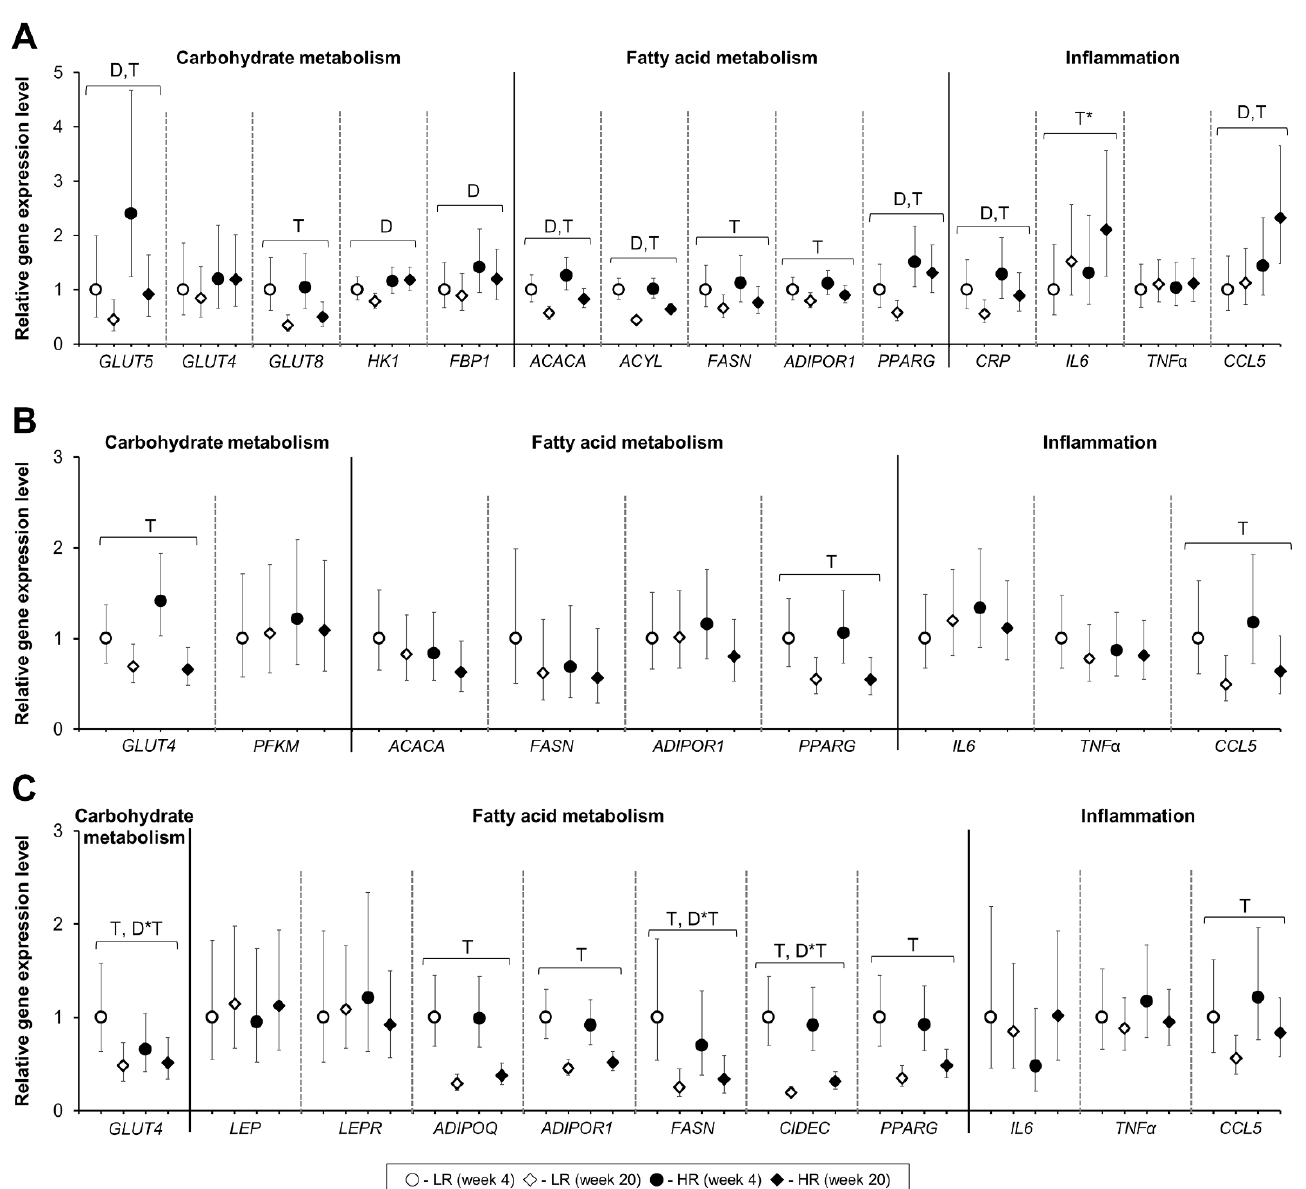
Figure 5. Gene expression of selected genes in the liver ( A ), muscle ( B ), and subcutaneous adipose tissue ( C ) collected at week 4 and week 20 of the dietary intervention from ad libitum fed female Gottingen Minipigs. Solute Carrier Family 2 (Facilitated Glucose/Fructose Transporter) Member 5 (GLUT5); Solute Carrier Family 2 (Facilitated Glucose Transporter) Member 4 (GLUT4); Solute Carrier Family 2 (Facilitated Glucose Transporter) Member 8 (GLUT8); Hexokinase 1 (HK1); Fructose-Bisphosphatase 1 (FBP1); Phosphofructokinase, Muscle (PFKM); Acetyl-Coenzyme A Carboxylase Alpha (ACACA); ATP-citrate lyase (ACYL); Fatty Acid Synthase (FASN); C-C Motif Chemokine Ligand 5/RANTES (CCL5); Adiponectin (ADIPOQ); Adiponectin receptor 1 (ADIPOR1); Leptin (LEP); Leptin Receptor (LEPR); Cell Death-Inducing DFFA Like Effector C (CIDEC); Peroxisome proliferator-activated receptor gamma (PPARG); C-reactive protein (CRP); Interleukin 6 (IL6); Tumor Necrosis Factor (TNF α ). Results are presented as ddCT values with 95% CI, reported relative to the LR diet at week 4. LR, lower-risk diet. HR, high-risk diet. Number of animals-liver: LR week 4 ( n = 10), LR week 20 ( n = 15), HR week 4 ( n = 11), HR week 20 ( n = 15). Number of animals-muscle: LR-HR week 4 ( n = 14), LR-HR week 20 ( n = 15). Number of animals-subcutaneous adipose tissue: LR-HR week 4 ( n = 8), LR-HR week 20 ( n = 15). D = effect of diet ( p < 0.05), T = effect of time ( p < 0.05). D*T = effect of interaction diet and time ( p < 0.05). T* = tendency effect of time (0.05 ≤ p <